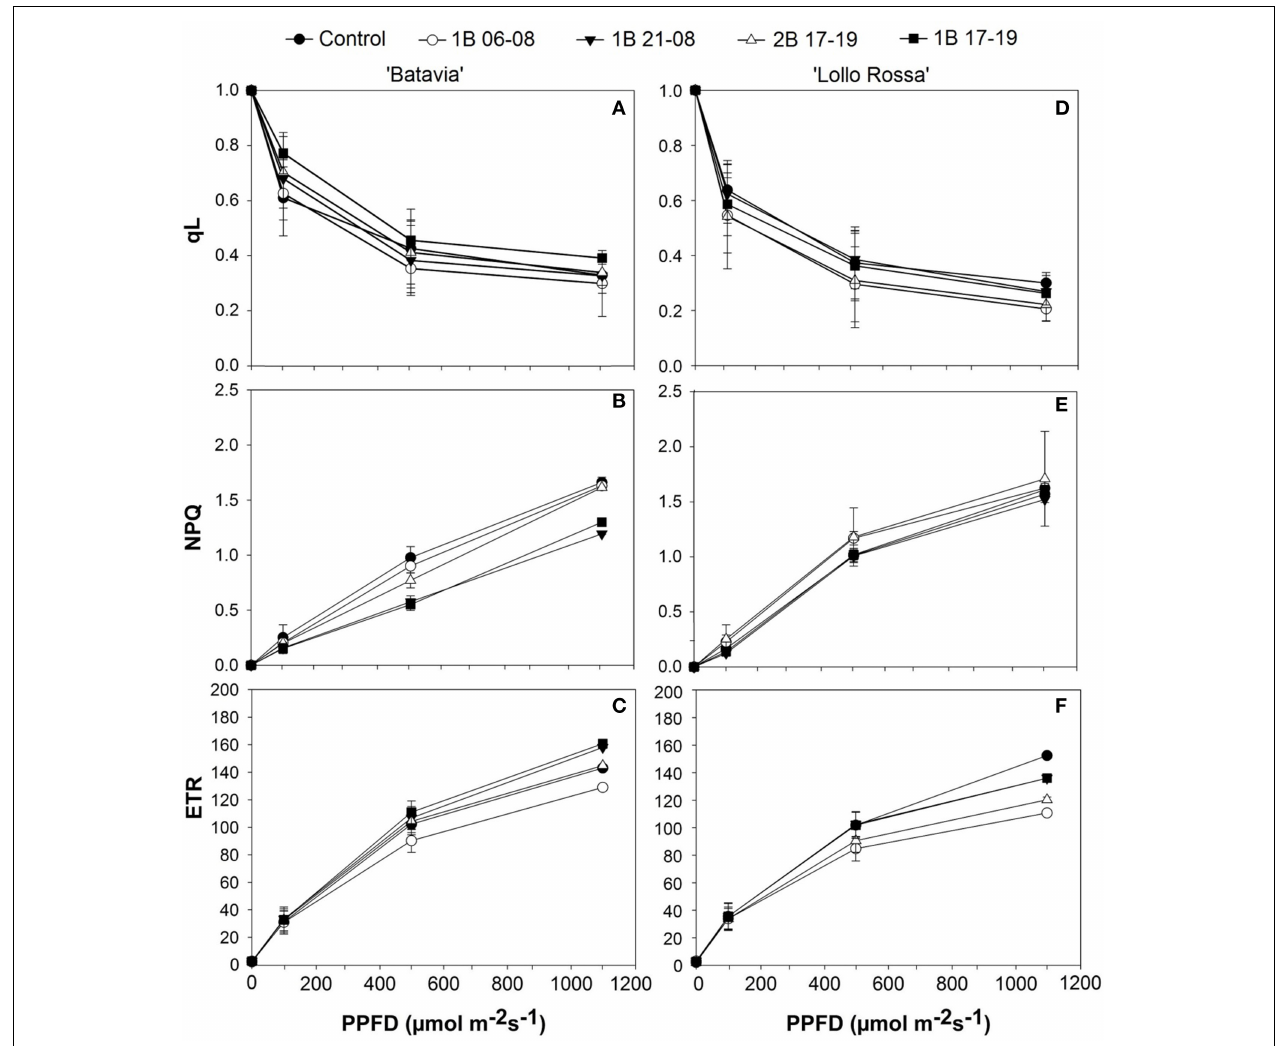
FIGURE 5 | Fraction of open PSII centers (q L ), non-photochemical quenching (NPQ), and electron transport rate (ETR) of Lactuca sativa “Batavia” (A–C) and “Lollo Rossa” (D–F) grown under the five different